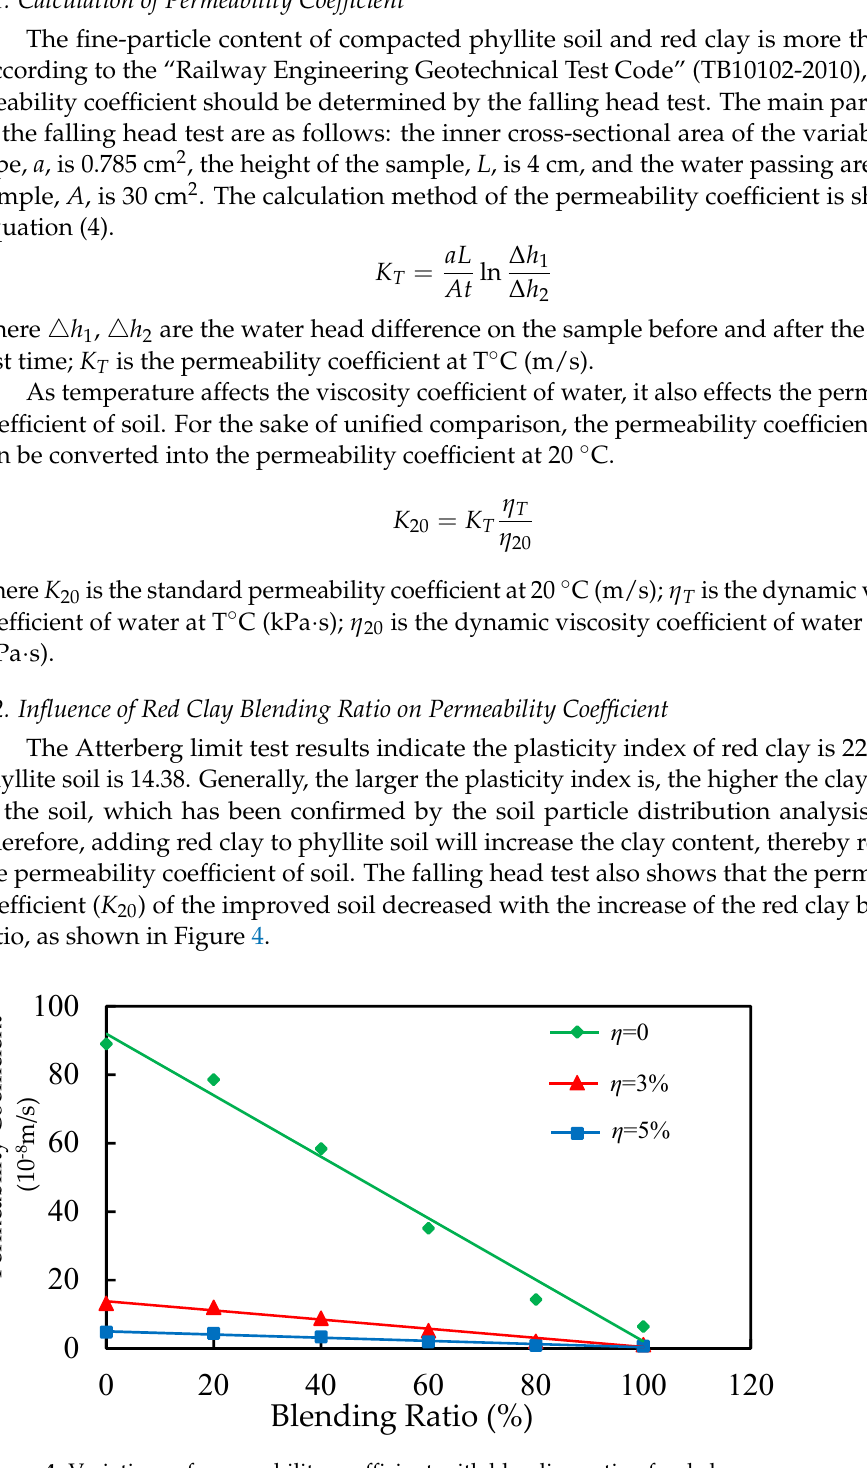
Figure 4. Variations of permeability coefficient with blending ratio of red clay.